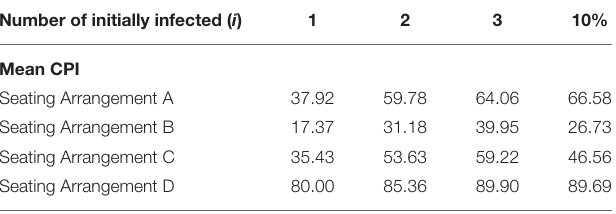
TABLE 4 | CPI for the four seating arrangements with transmission rate γ = 0.20. Number of initially infected ( i )